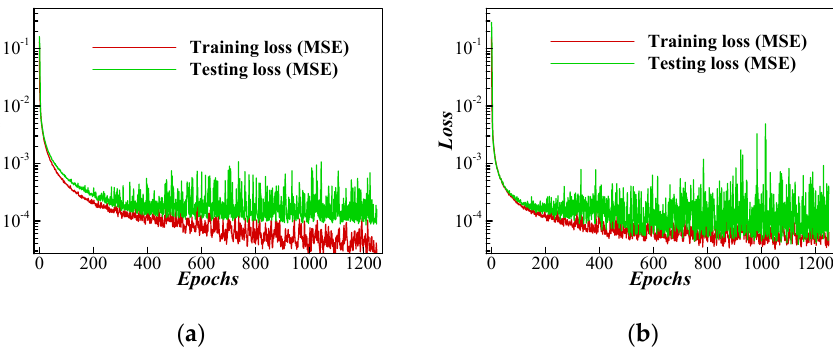
Figure 9. Converge history of the loss function in CNN5-3 for ( a ) upper surface and ( b ) lower surface.